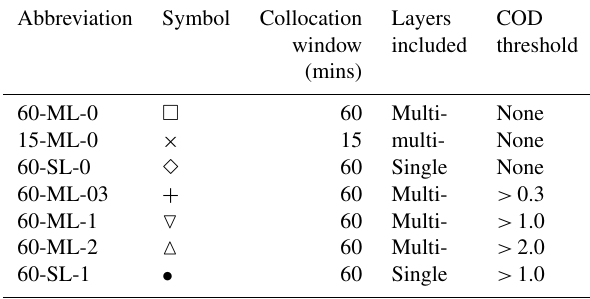
Table 1. Descriptions of the seven sets of collocation criteria to be evaluated, the abbreviations by which they are referenced in the text, and the symbols by which they are referenced in